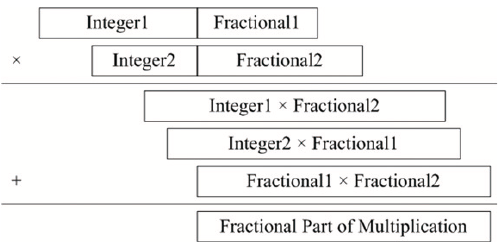
Figure 2. Fixed-point calculation for the phase of the cosine function.